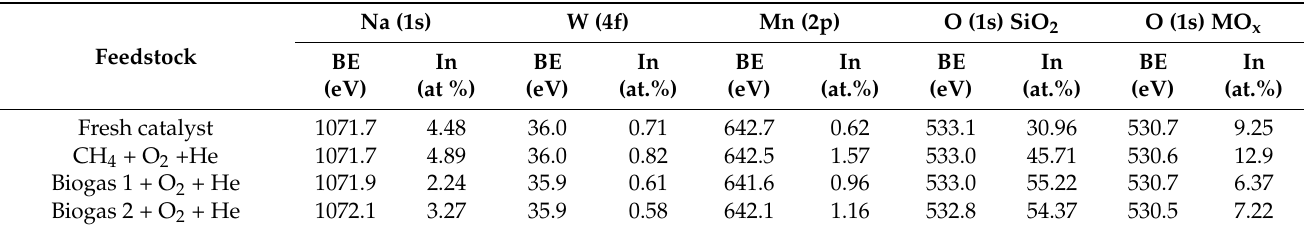
Table 2. XPS results for fresh and used Mn-Na 2 WO 4 /SiO 2 catalysts a